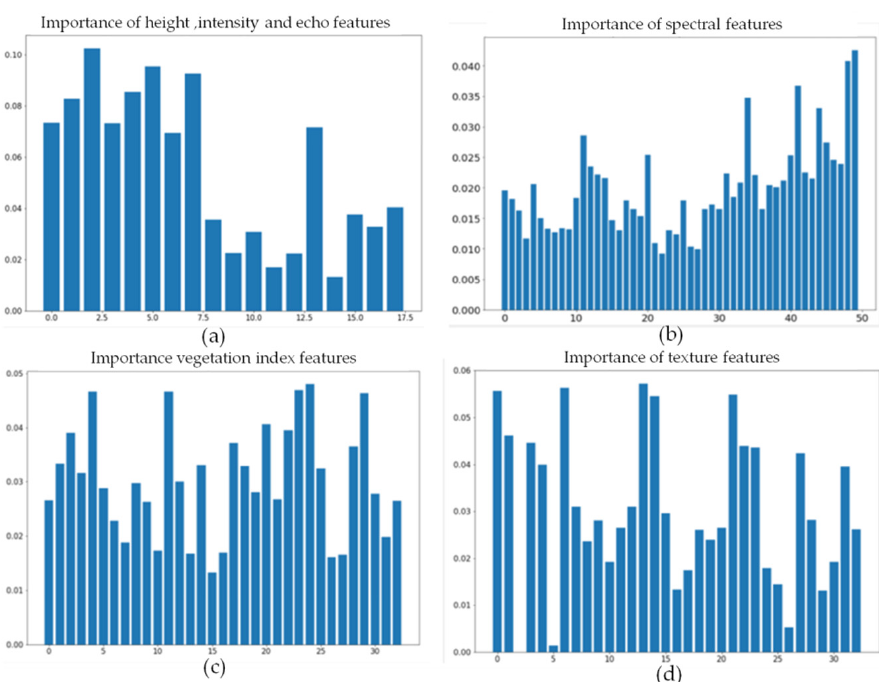
Figure 12. Importance ranking of four feature factors: ( a ) height, intensity, and echo; ( b ) spectrum; ( c ) vegetation index; ( d ) texture. The x-axis is the number of feature factors, and the y-axis is the importance of the input feature factors.